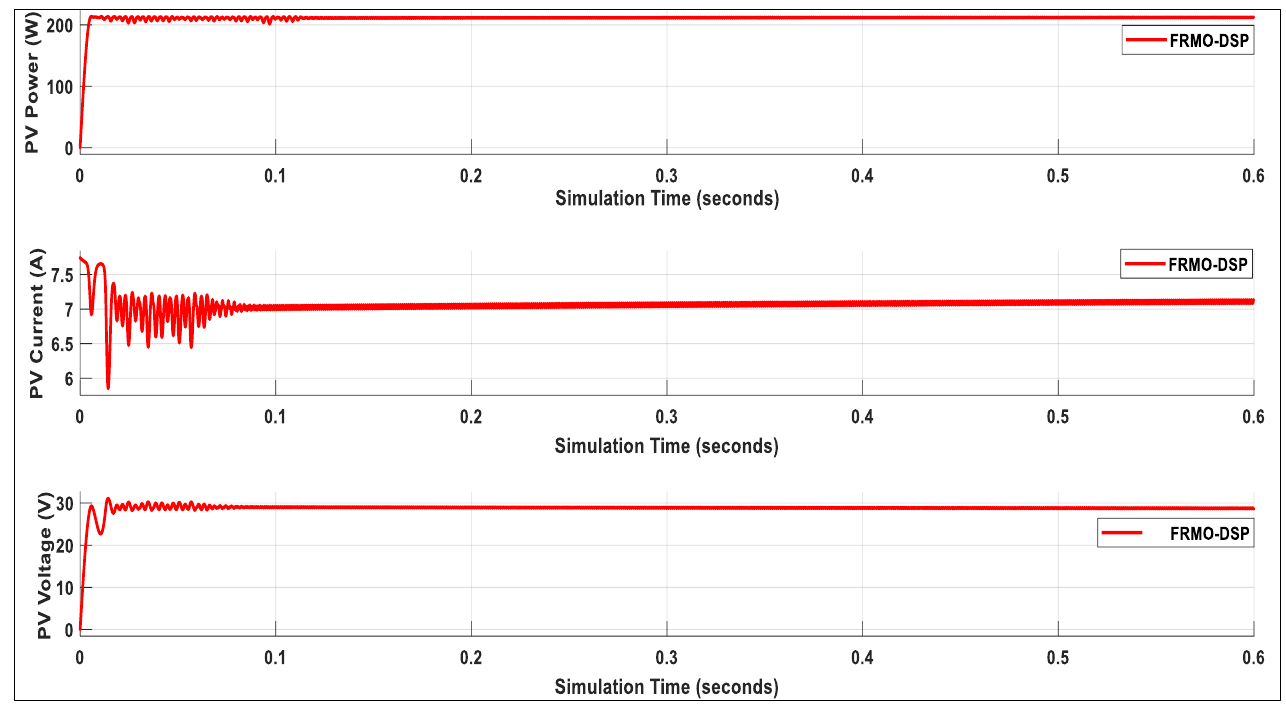
Figure 15. PSC pattern 2 FRMO-DSP MPPT results (case study 2).